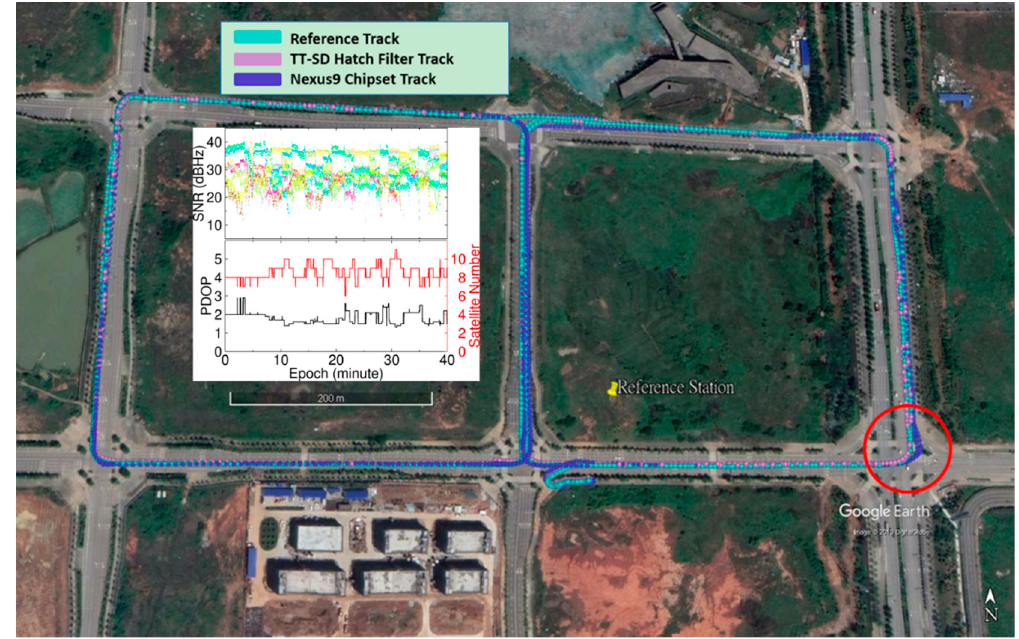
Figure 10. The reference track, track of the TT-SD Hatch filter (Three-Thresholds and Single-Difference Hatch filter) solution ( top ) and track of the GNSS chip solution ( bottom ). The red circle indicates a corner in the track. The analyses including SNR (Signal-to-Noise Ratio), PDOP (Position Dilution of Precision) and observed satellite number for the kinematic experiment are plotted in the middle panel. The dots with different colors in the SNR (Signal-to-Noise Ratio) subfigure denote different satellites.